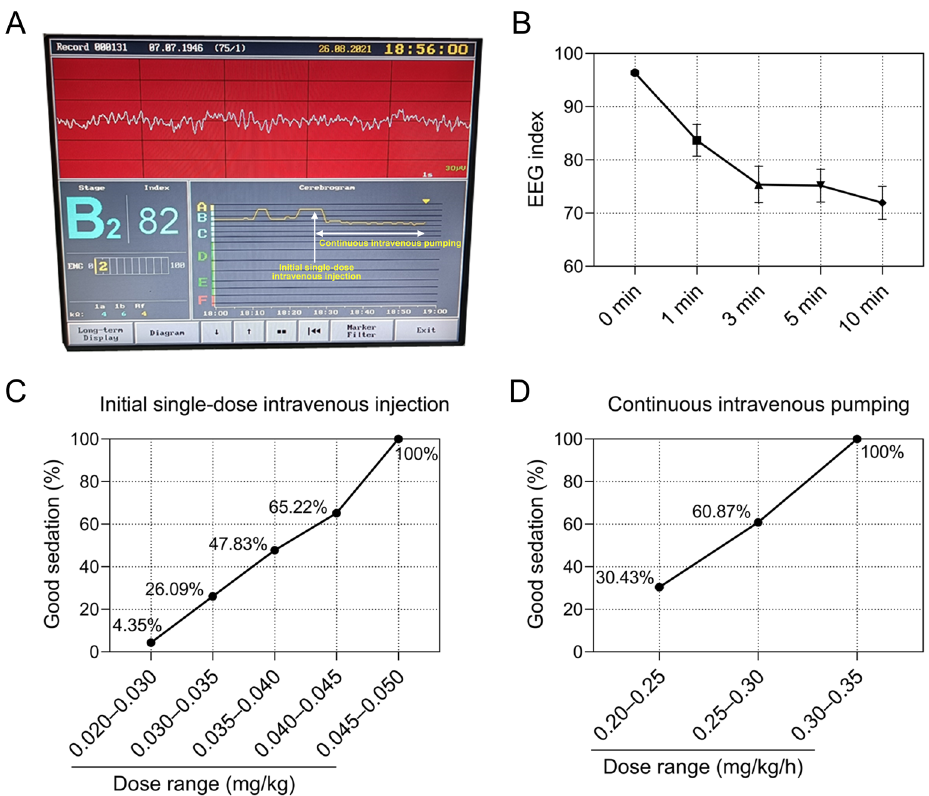
Figure 2. The optimal dosing of remimazolam besylate for a single intravenous infusion and subsequent optimal dosing for continuous pumping. ( A ) The Narcotrend monitoring view of one patient; the real-time electroencephalogram (EEG) and Narcotrend index (NTI) before and after the administration of remimazolam besylate. ( B ) The change in the average NTI of 23 patients at 0, 1, 3, 5, and 10 min after the administration of remimazolam besylate. Good sedation rates were achieved at different ranges of initial loading doses ( C ) and subsequent maintenance doses ( D ). Good sedation was defined as a RASS score of –3––1 and an NTI value of